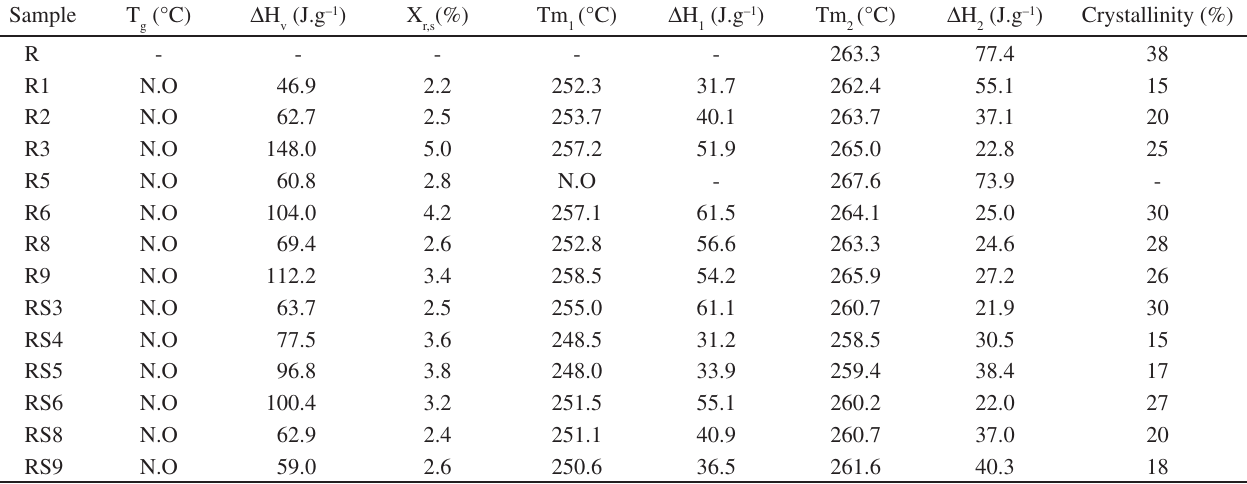
, and crystallinity of sample R nanofibers. r.s